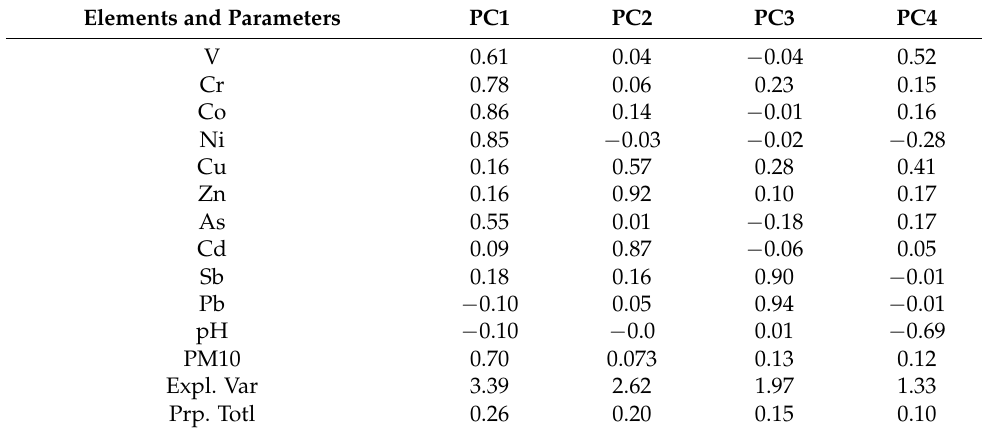
Table 5. Varimax principal component loadings for PTE concentrations, pH and PM10 in the studied samples of road